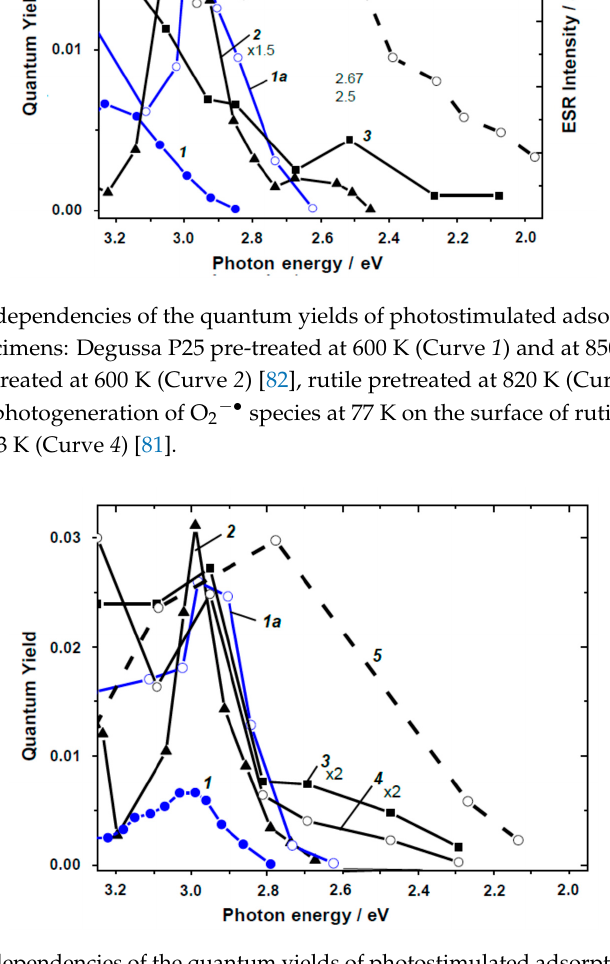
Figure 13. Spectral dependencies of the quantum yields of photostimulated adsorption of H 2 (Curves 1 , 1a , 2 , and 3 ) and CH 4 (Curve 4 ) on the surface of TiO 2 specimens: Degussa P25 pre-treated at 600 K (Curve 1 ) and at 850 K (Curve 1a ) [82], rutile (Aldrich) pre-treated at 600 K (Curve 2 ) [82], rutile (Curves 3 and 4 ) [77]. Spectral dependence of the efficiency of photogeneration of a hole species [O – O 2 ] at 77 K on the surface of anatase pretreated at 800 K (Curve 5 ) 120. Church of 2000 / Richard Meier & Partners. Available online: https://www.archdaily.com/20105/church-of-2000-